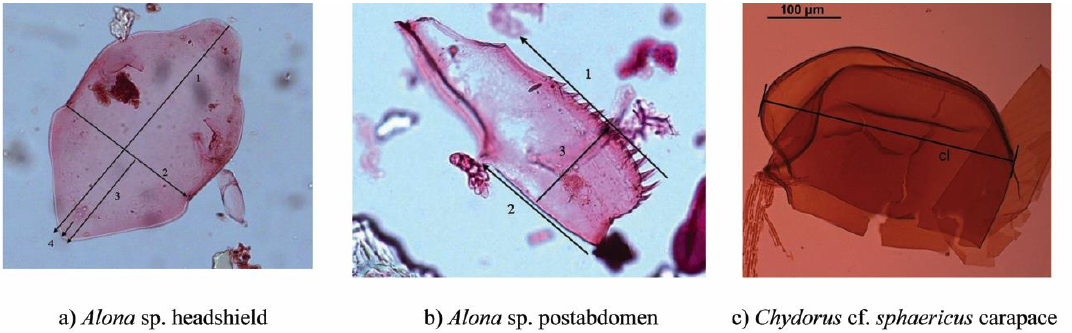
Figure 2. Measured morphological characteristics: ( a ) Alona headshields: 1. total length, 2. width, 3. distal length, 4. pore distance of headshield; ( b ) Alona postabdomens: 1. length, 2. ventral length, 3. width of postabdomen; ( c ) Chydorus cf. sphaericus carapaces: cl: length of carapace.